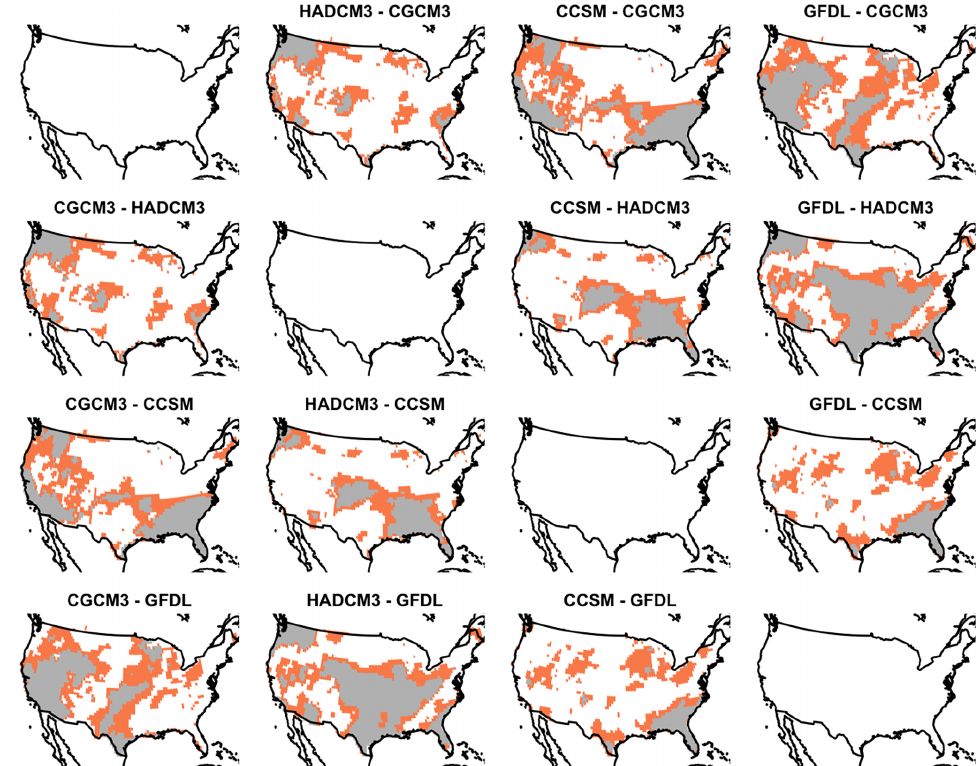
Figure A2. A comparison of the nonzero-effect regions of the average pairwise difference for GCM effects of the APL model using both pointwise and CoPE methods. The grey coloring indicates significant locations at the 0.10 level for both methods, while the orange coloring indicates that the effect is significant for pointwise inference